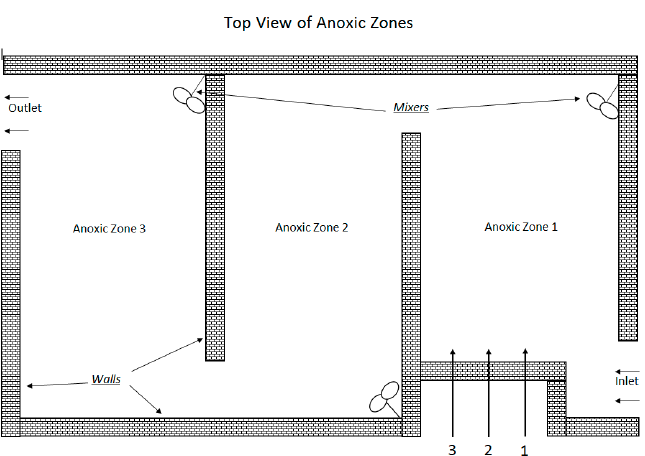
Figure 4. Boundary Conditions of a zone.